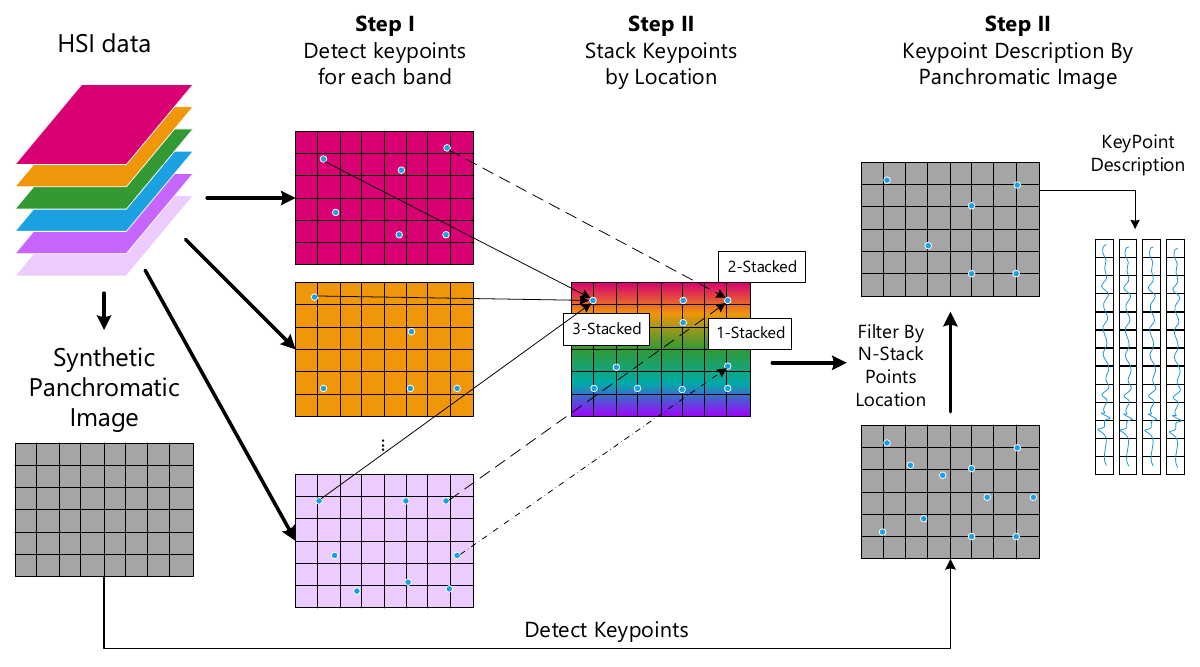
Figure 1. Schematic of the proposed stacked local feature detector for hyperspectral image